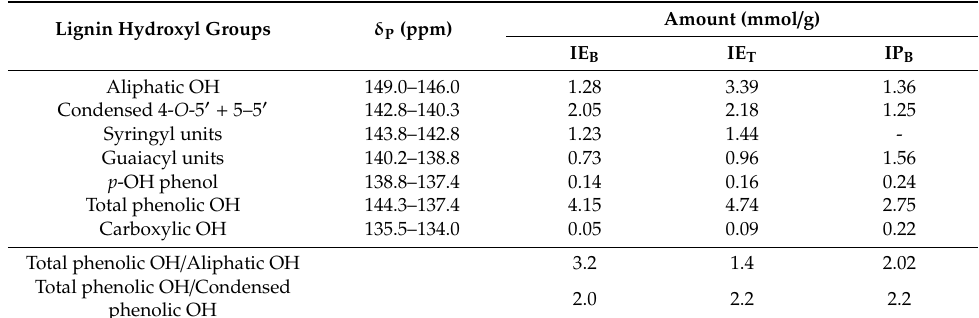
Table 2. Results from quantitative 31 P-NMR analysis of E. nitens lignin recovered after delignification treatment for both ionic liquids and the Ionosolv lignin from Pinus pinaster wood ( IP B